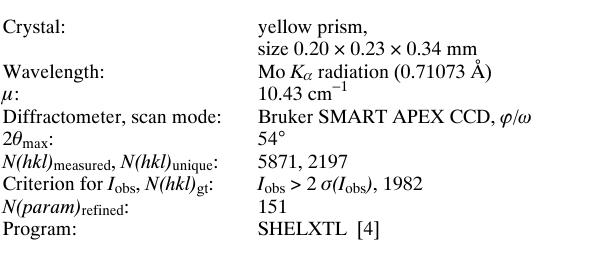
Table 1. D a t a collection a nd h a ndling.